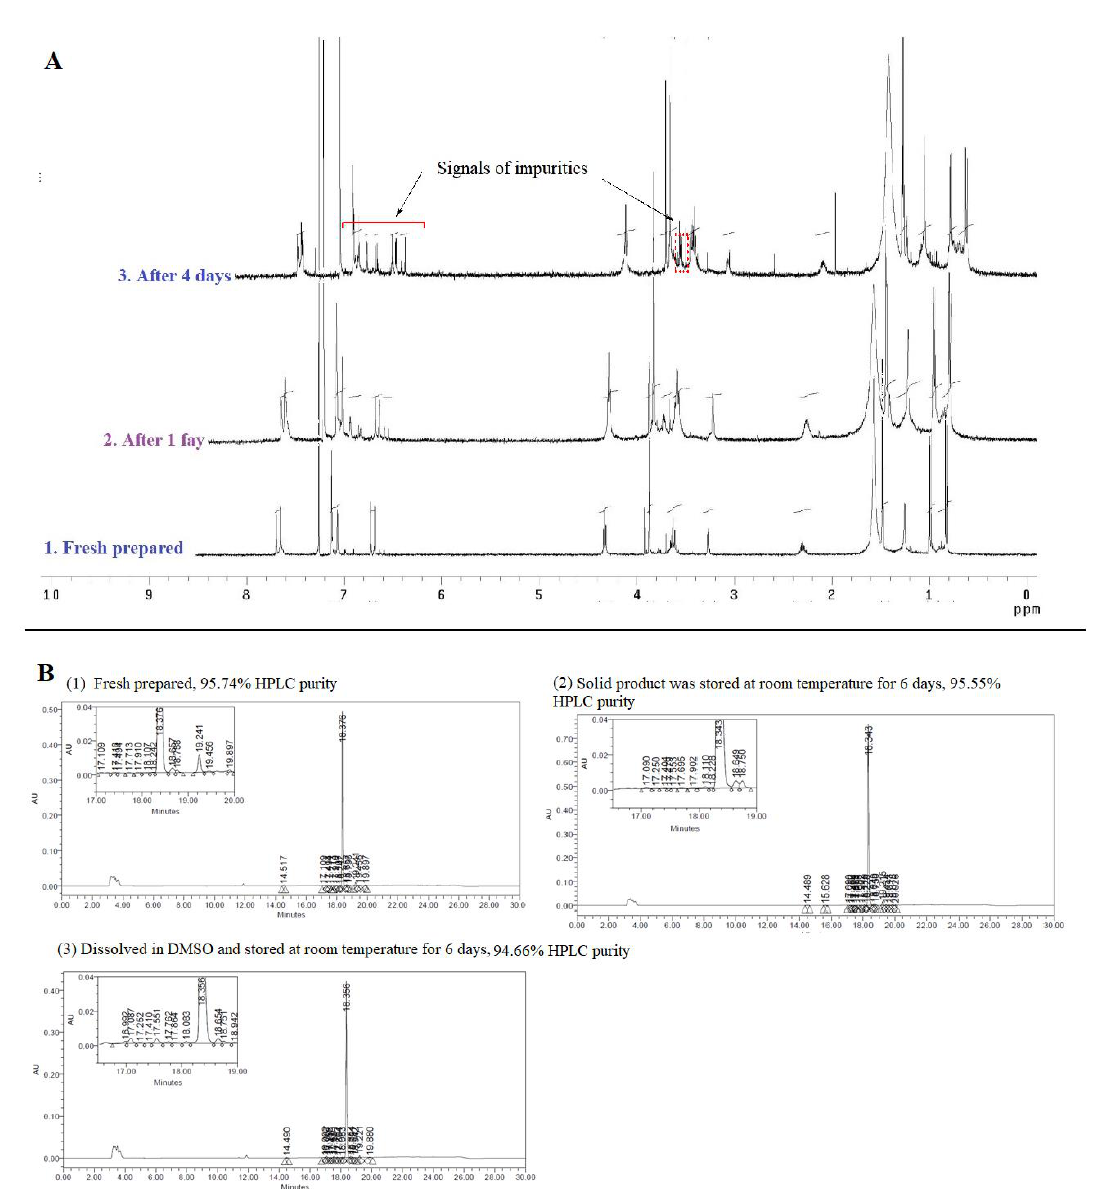
Figure 2. The stability assessments of 2 and 2-TFA . ( A ) A clear solution of 2 in d -chloroform was subjected to a purity assessment by 1 H NMR spectroscopy at various storage times (fresh prepared ( ≤ 1 h); 1 day; 4 days). ( B ) The HPLC purity of fresh prepared 2-TFA was 95.74%. The fresh prepared 2-TFA in a solid state was stored at room temperature for another 6 days and then dissolved in water for HPLC analysis. The HPLC purity was decided as 95.55%. The fresh prepared 2-TFA was dissolved in DMSO and the resulting solution was stored at room temperature for another 6 days. HPLC purity of 2-TFA in the DMSO solution was 94.66%.